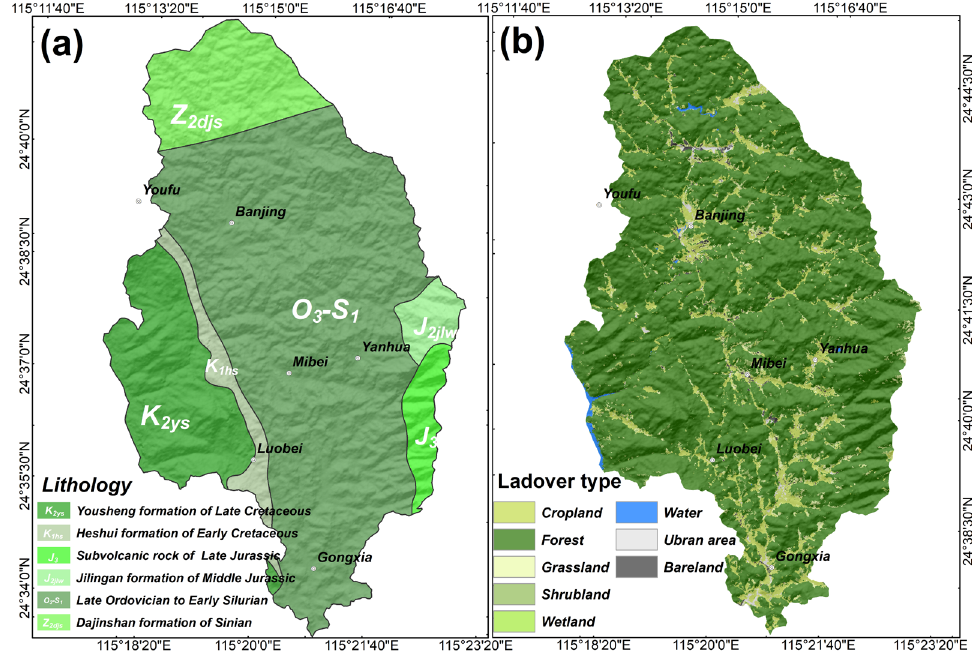
Figure 2. ( a ) Geological map of the study area obtained from 1:200,000 geological maps published by China Geological Survey (http://dcc.cgs.gov.cn/, accessed on 1 July 2022); ( b ) the land use type map of the study area derived from the 10-m resolution global land cover results [65].